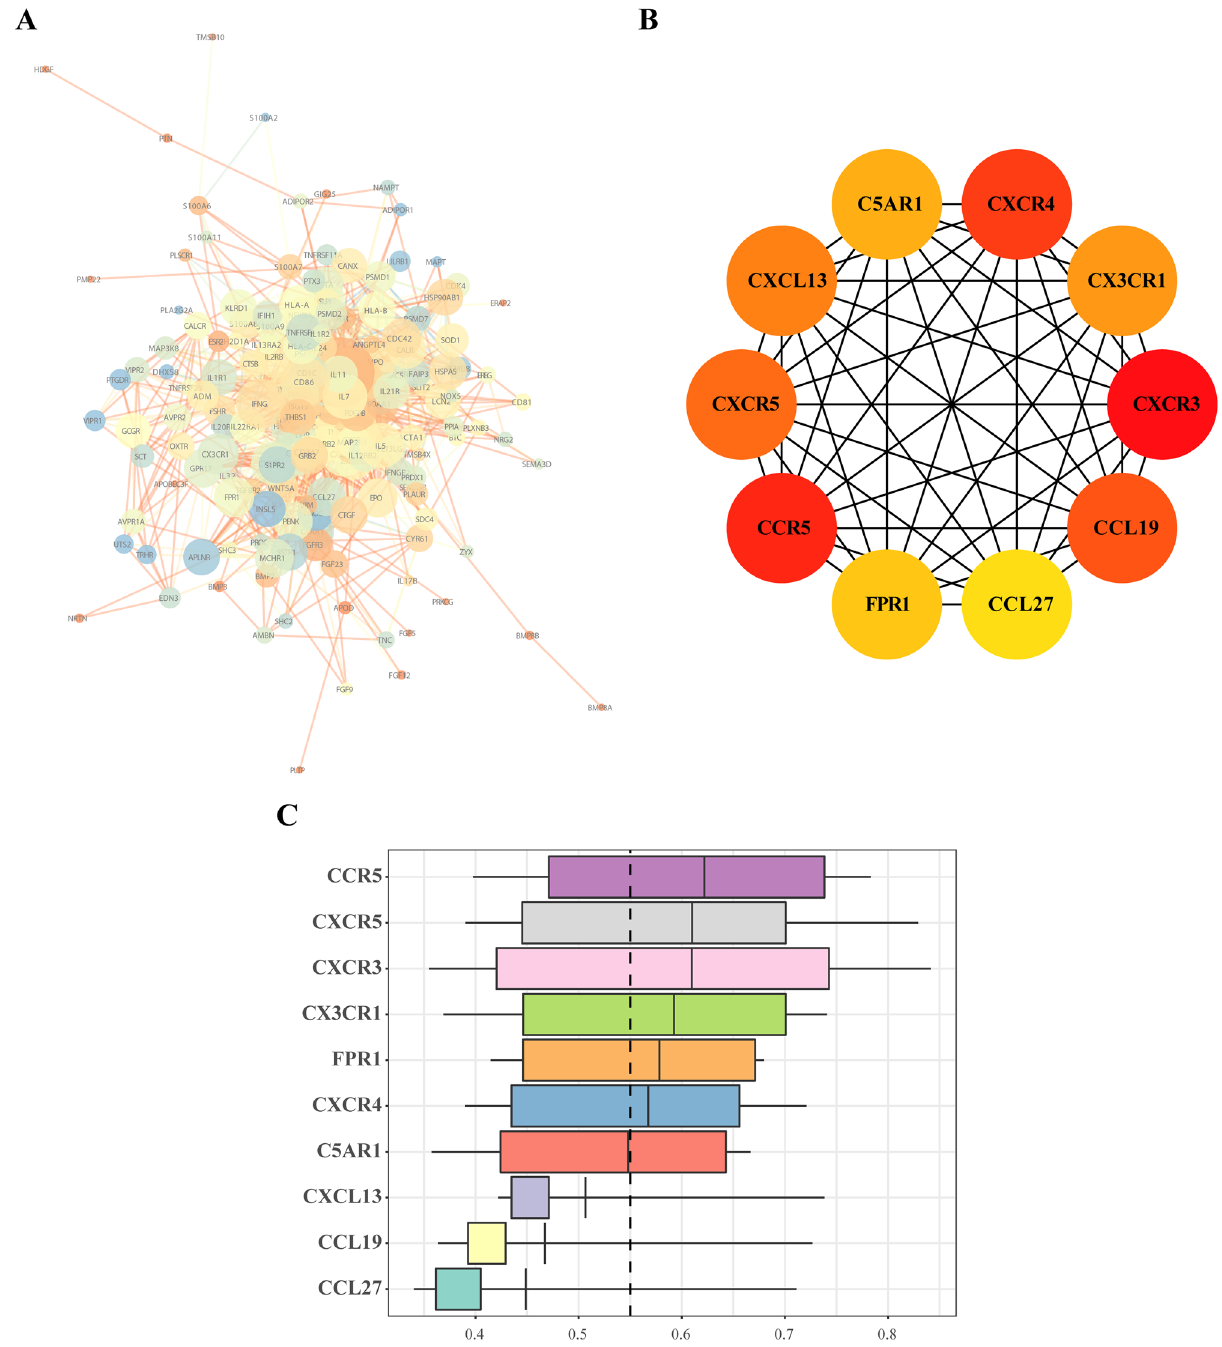
Figure 5. PPI network analysis and functional similarity analysis of DEIRGs. ( A ) PPI network analysis graph, the node size indicates the clustering coefficient; a larger node indicates a larger the clustering coefficient, and thus a greater proportion of genes in the network. The node color indicates the degree; a higher degree indicates greater connectedness of the node. Blue represents a higher degree, yellow represents a medium degree, and orange indicates a minimum degree. The line thickness represents the overall score. A higher score results in a thicker line, indicating that the interaction between the two proteins is stronger. ( B ) Schematic representation of hub immune-related genes. ( C ) Hub immune-related gene similarity analysis plot, with the abscissa as the similarity